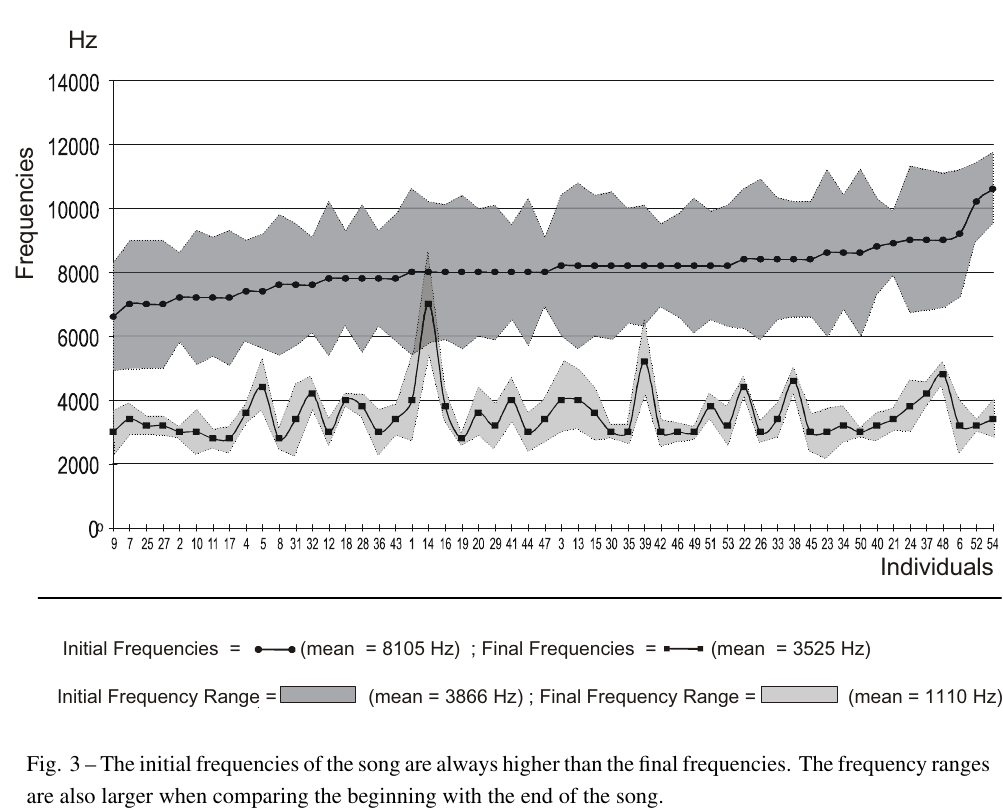
Fig. 3 – The initial frequencies of the song are always higher than the final frequencies. The frequency ranges are also larger when comparing the beginning with the end of the song.